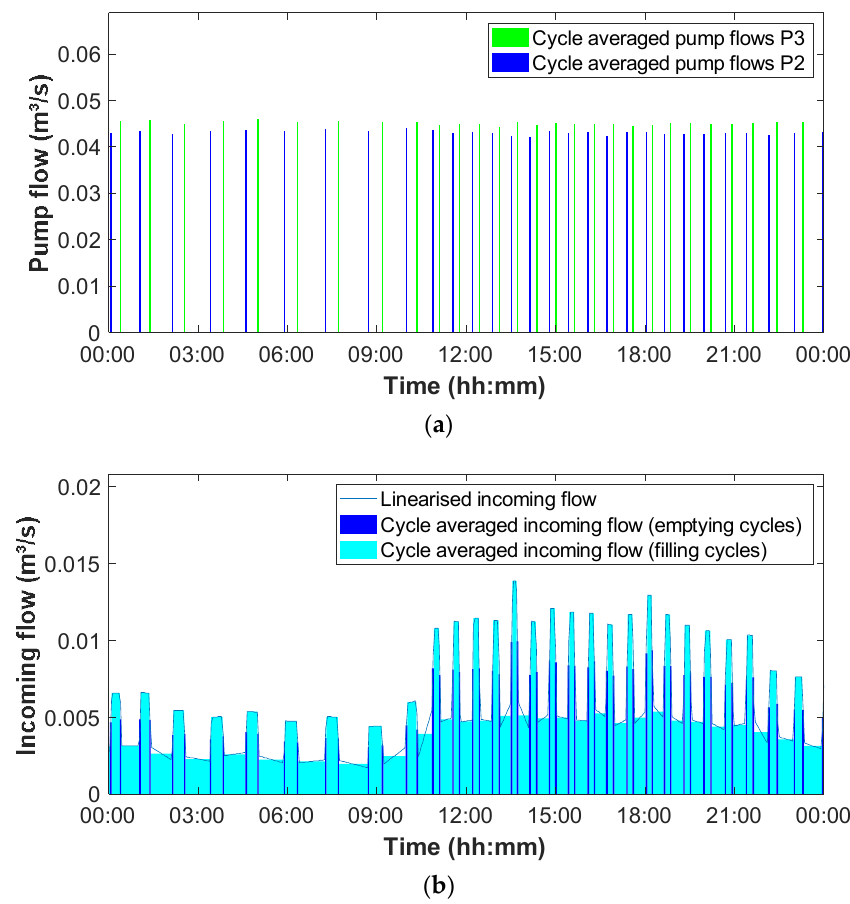
Figure 8. Effect of missing pump loggings on the calculated cycle flows: ( a ) pumped flows per cycle per pump (top); ( b ) average incoming flows for filling and emptying cycles and linearised flows for all cycles (bottom) (PS Wijgmaalsesteenweg).